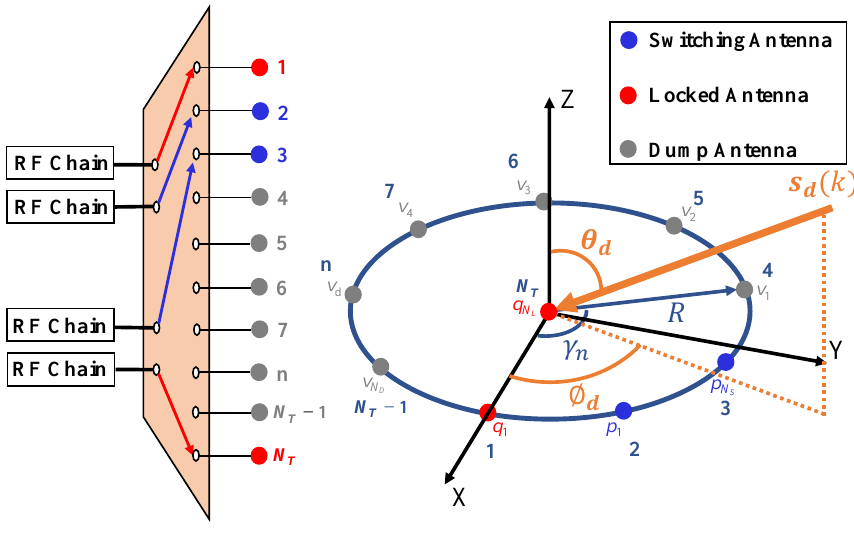
Figure 1. System